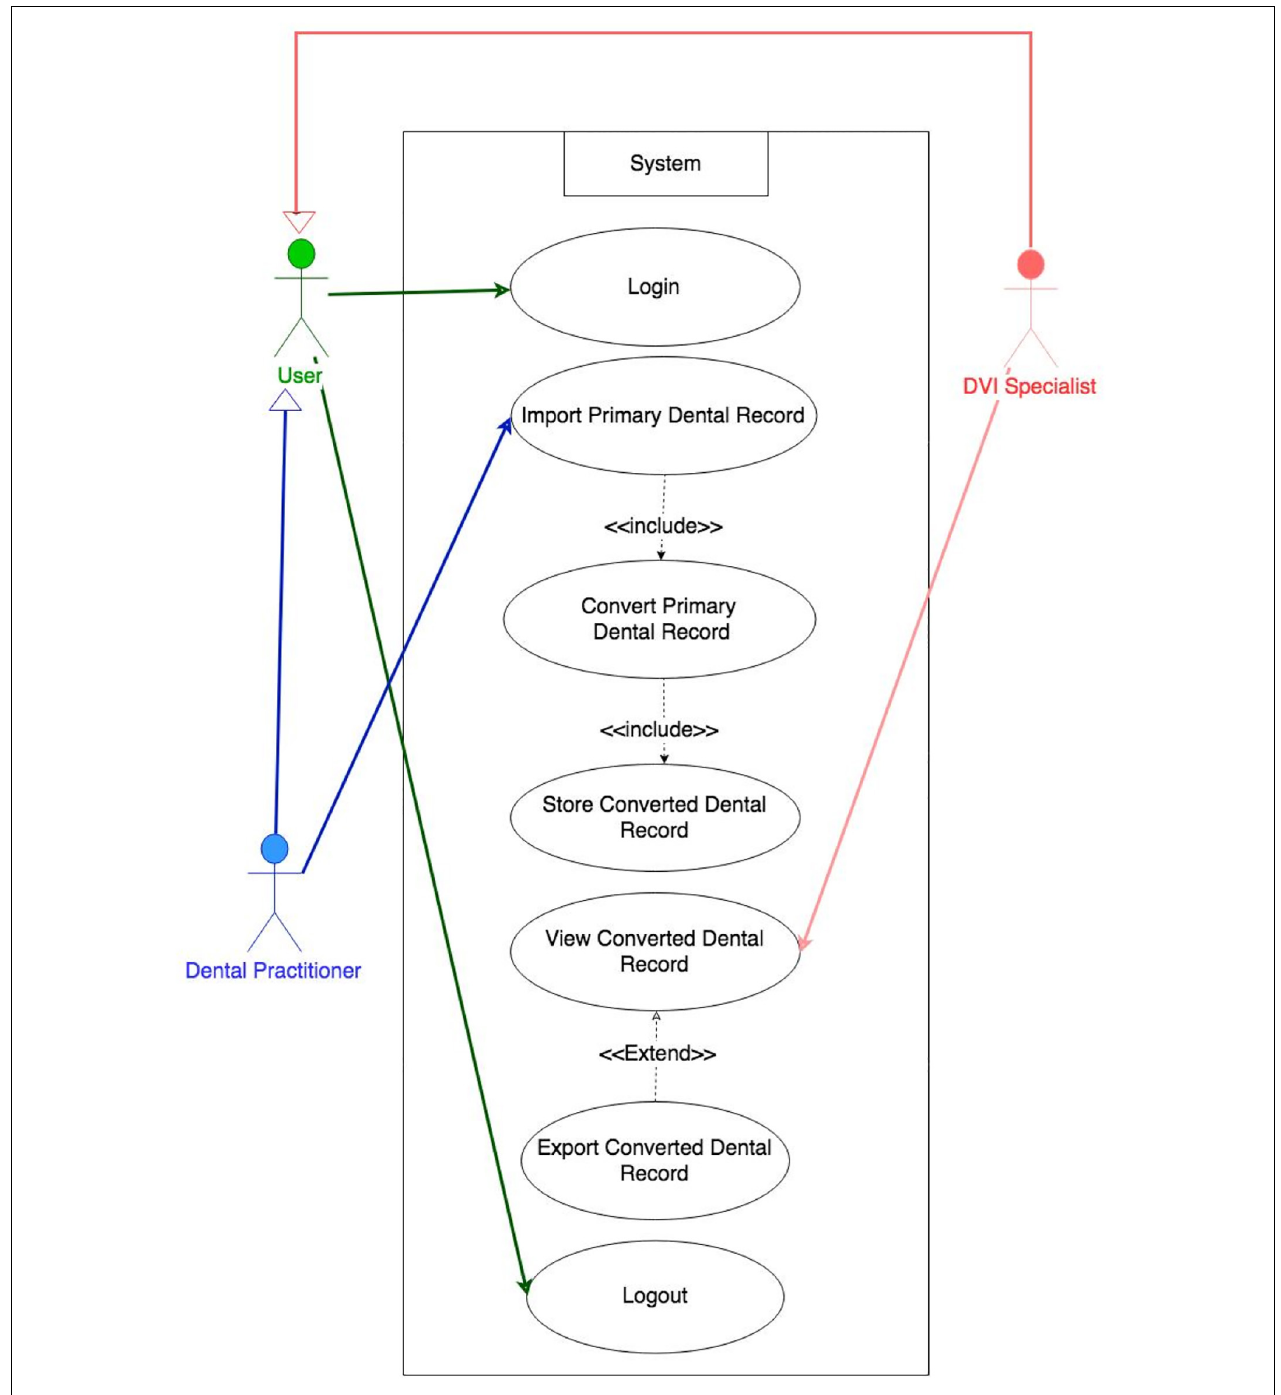
FIGURE 4 | AM data repositories for global living citizens system use case diagram (AlQahtani et al., 2019).